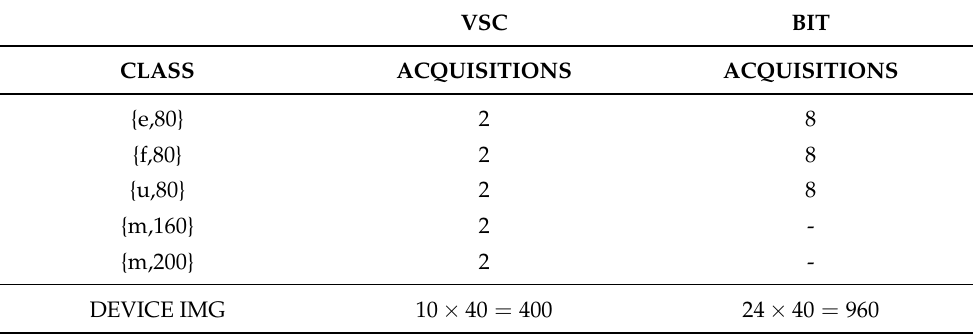
Table 3. Dataset